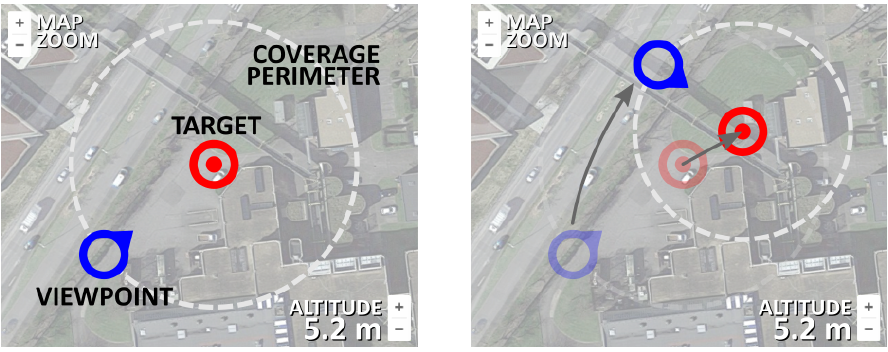
Figure 10. Fleet target